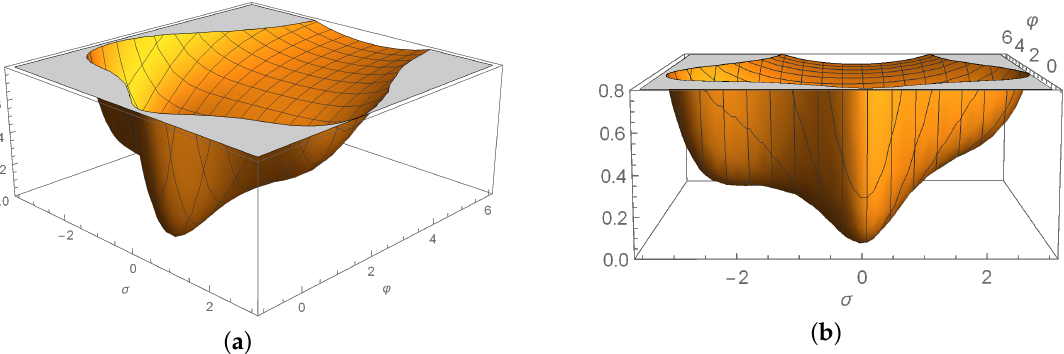
Figure 5. The scalar potential for γ = 0, δ = 0.1, and ζ = 0.033407, from the two perspectives ( a ) and ( b